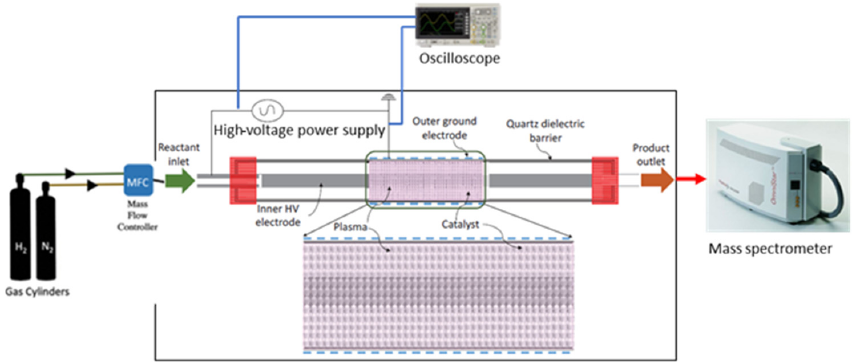
Figure 3. Scheme of the experimental plant used for the NTP-assisted ammonia synthesis.